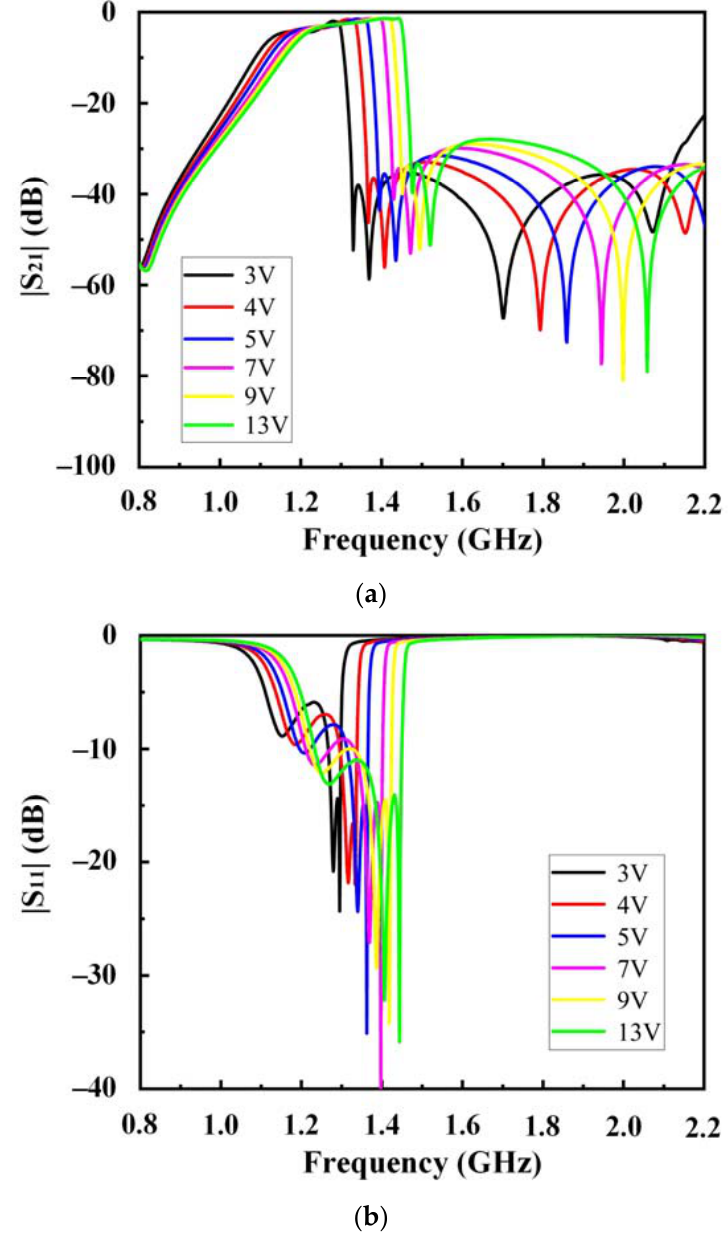
Figure 9. Measured ( a ) S 21 ; ( b ) S 11 of the four-pole HTS-tunable filter. Table 2. Experimental measurement results of the as-fabricated Table 3. Performances of the proposed and other filters. Ref.